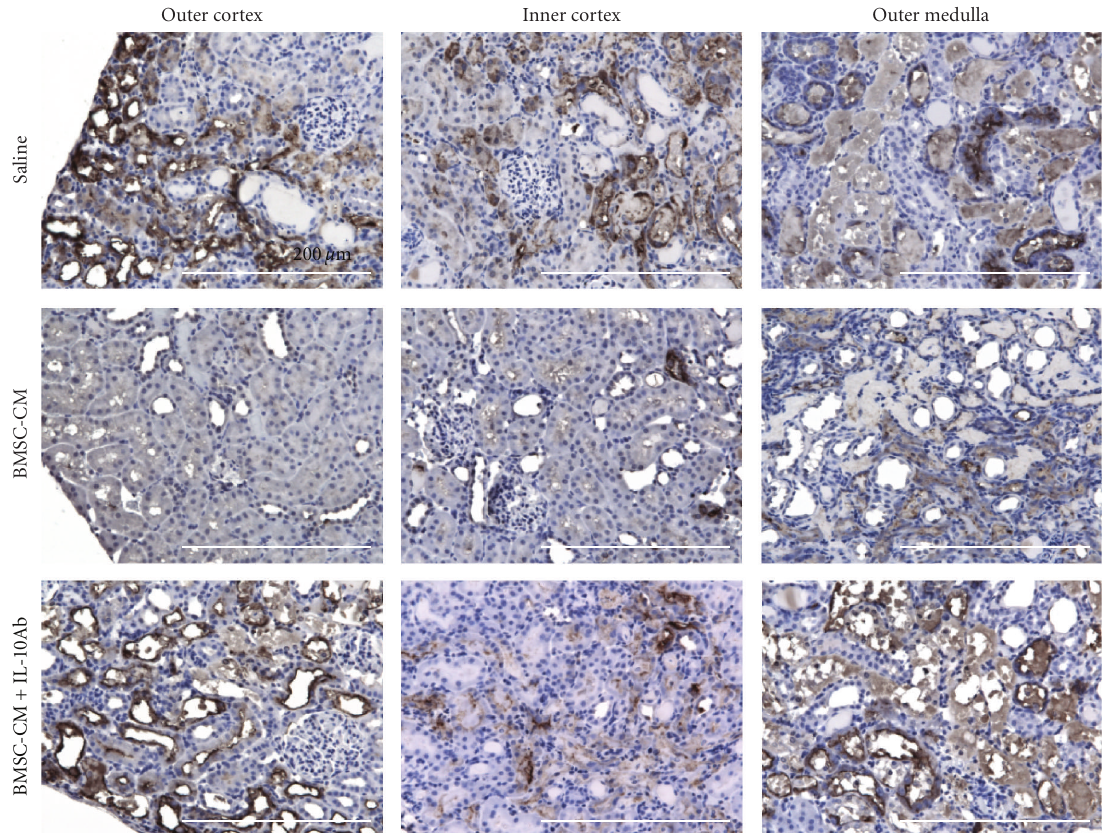
Figure 10: Kidney injury molecule-1 (KIM-1) positive staining is more extensive when IL-10 antibodies are coadministered with BMSC-CM compared to BMSC-CM alone. Immunohistochemical staining for KIM-1 of kidneys from AKI rats treated with either BMSC-CM plus a neutralizing IL-10 antibody ( n = 3), BMSC-CM ( n = 3), or saline ( n = 3). Animals were sacrificed at 5 days after induction of AKI for tissue harvesting. Scale bar = 200 μ